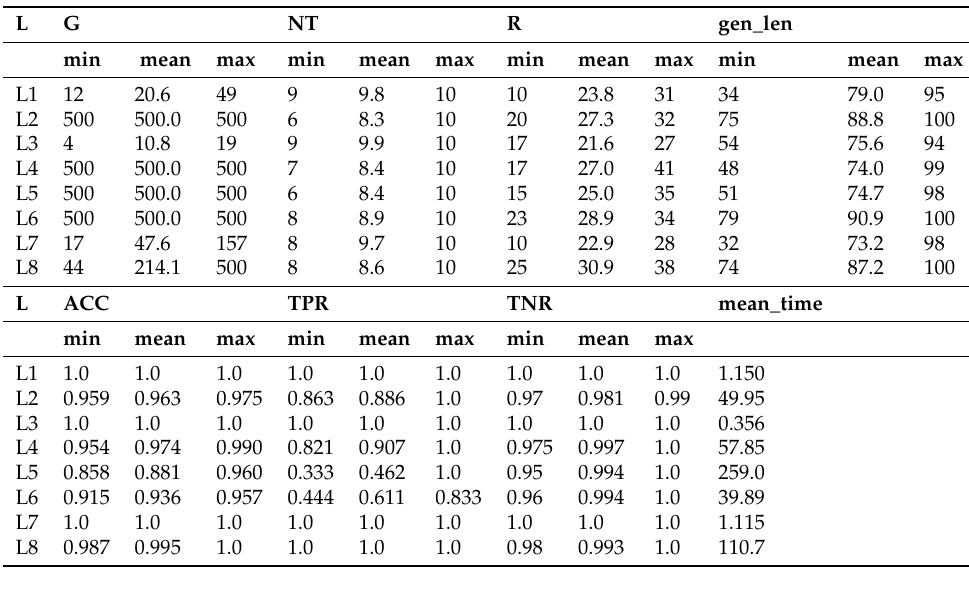
Table 2. Experimental results from L 1 − 8 .